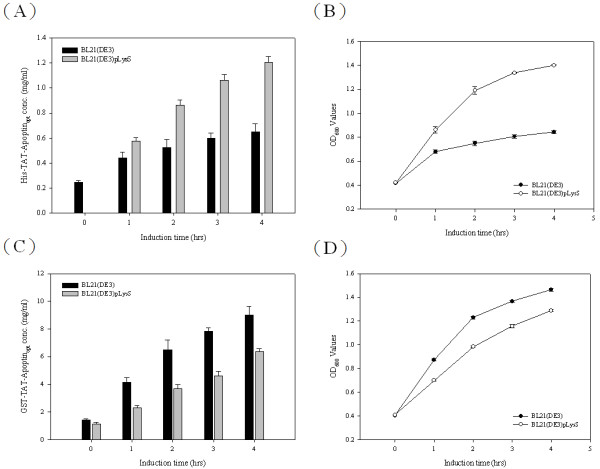
Productivities of TAT-Apoptinoptprotein and the growth curves of two recombinantE. colistrains. The productivities of His-TAT-Apoptinopt (A) and GST-TAT-Apoptinopt (C) using two E. coli strains, BL21(DE3) and BL21(DE3)pLysS containing either pET-TAT-VP3opt or pGEX-TAT-VP3opt, respectively, are shown over a time course after IPTG induction at 37 °C. The growth curves of BL21(DE3) and BL21(DE3)pLysS expressing His-TAT-Apoptinopt (B) and GST-TAT-Apoptinopt (D) in LB medium post-induction.